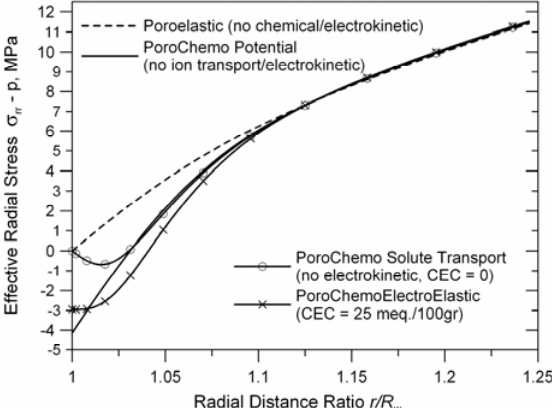
Fig. 5 – Effective radial stress distribution in the formation after t = 15 minutes into drilling for high mud activity (low mud f . 93 > a f . salinity): a o = 0 mud = 0